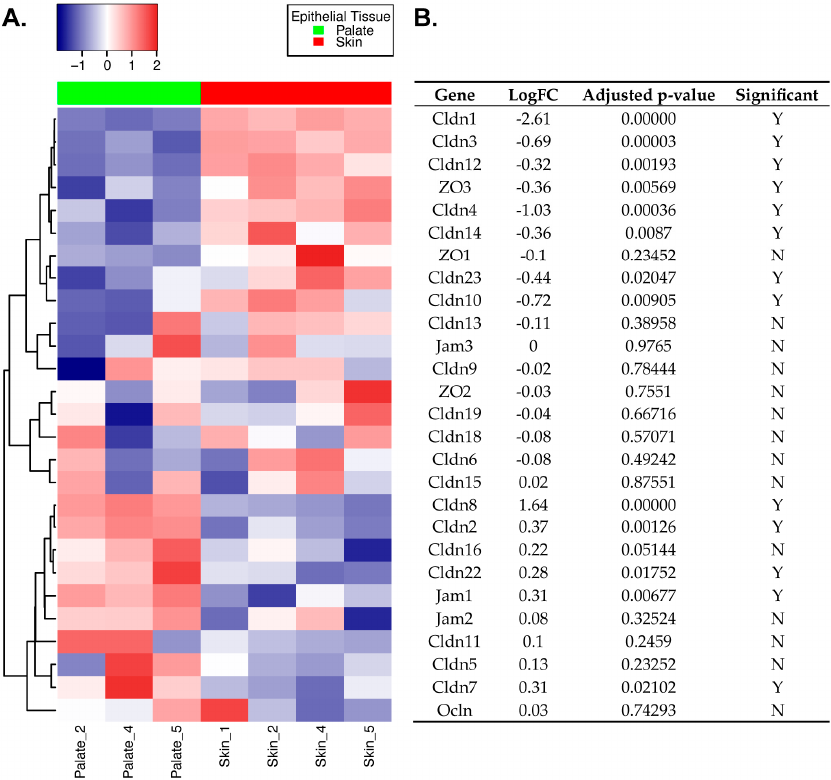
Figure 1. Differential expression of tight junction molecules in primary mouse skin and oral epithelial cells. Skin epithelium obtained from the tails of mice were compared to oral epithelium obtained from the hard palate of mice using the R/Bioconductor package linear models for microarray data (limma). ( A ) Heatmap displaying gene expression profiles of the 27 tight junction (TJ) genes analyzed. Genes were hierarchically clustered using the Euclidean distance measure and complete clustering, with gene expression scaled across rows. Each row is a gene and each column is a sample. ( B ) Table of limma results for the corresponding 27 TJ genes analyzed. The gene column is aligned to match and annotate the corresponding heatmap in A (left). LogFC is the calculated log 2 fold change between oral and skin epithelium, with positive values corresponding to over expression in palate and negative values corresponding to over expression in skin. Adjusted p -value is listed in the second column, and the third column identifies whether or not the gene was significantly differentially expressed (Y = yes, N = no) using an adjusted p -value of p < 0.05. n = 4 mice for skin and n = 3 mice for palate epithelium. Data from one of the palate samples (Palate_1) was excluded in this analysis due to its poor quality (see the Materials and Methods